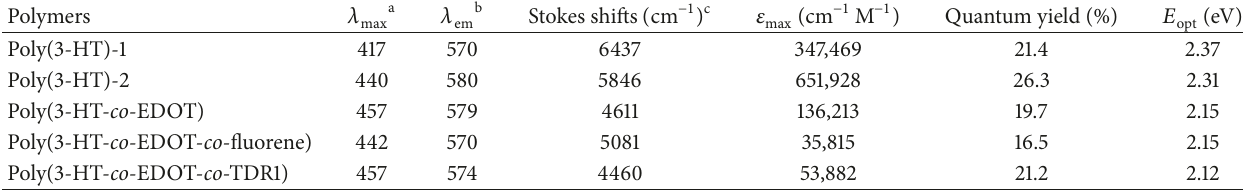
Table 5: Optical properties of the polymers.